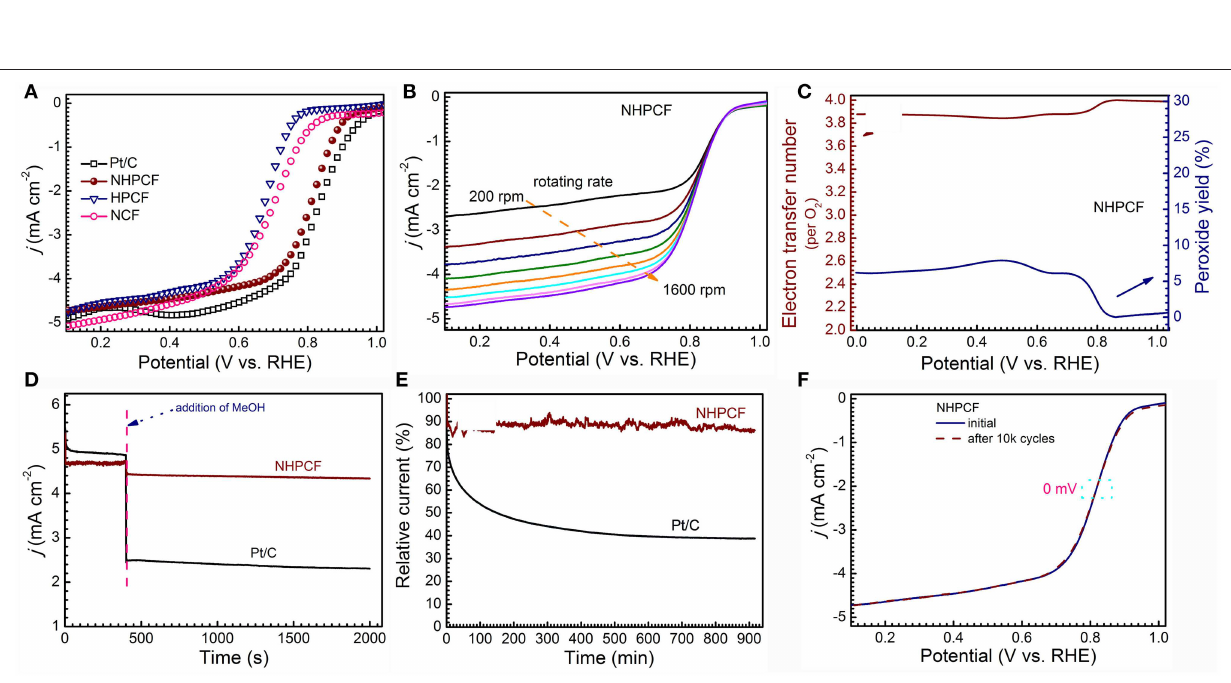
Frontiers in Chemistry |